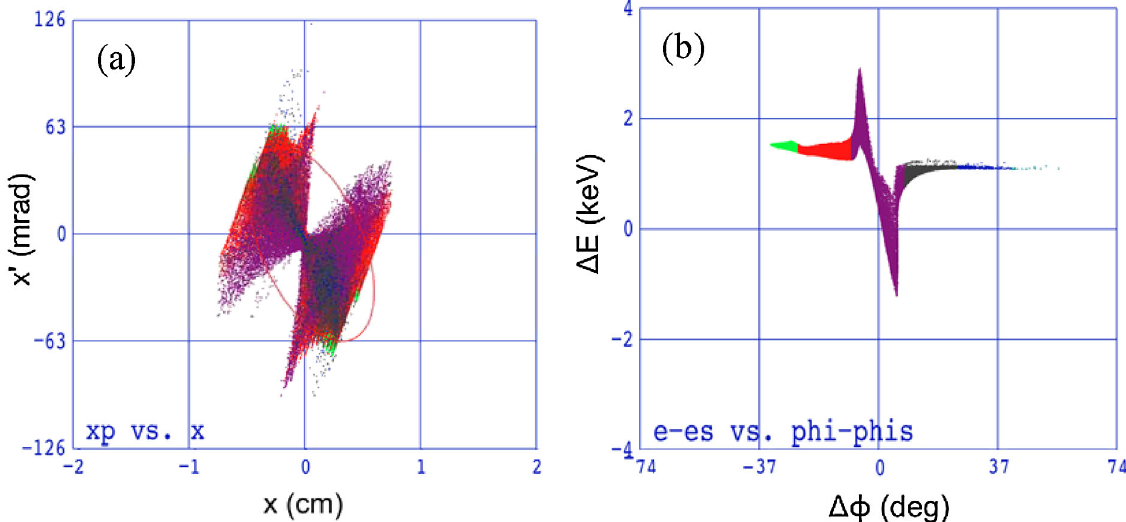
FIG. 18. (a) Transverse and (b) longitudinal phase space from the PARMELA simulation of Fig. 17 at the exit of the gun ( z ¼ 5 : 0 cm ). The normalized transverse emittance is 25 mm mrad and the longitudinal emittance is 17 keV psec. Particles are grouped by color into six longitudinal slices, with each slice containing particles of a given range in rf phase at z ¼ 5 : 0 cm